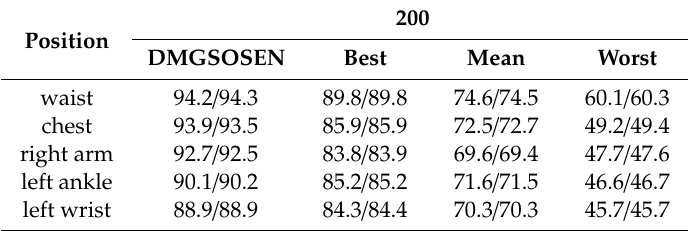
Table 5. Performance of the ensembles for initial pool sizes of 200 (Accuracy / F1%).